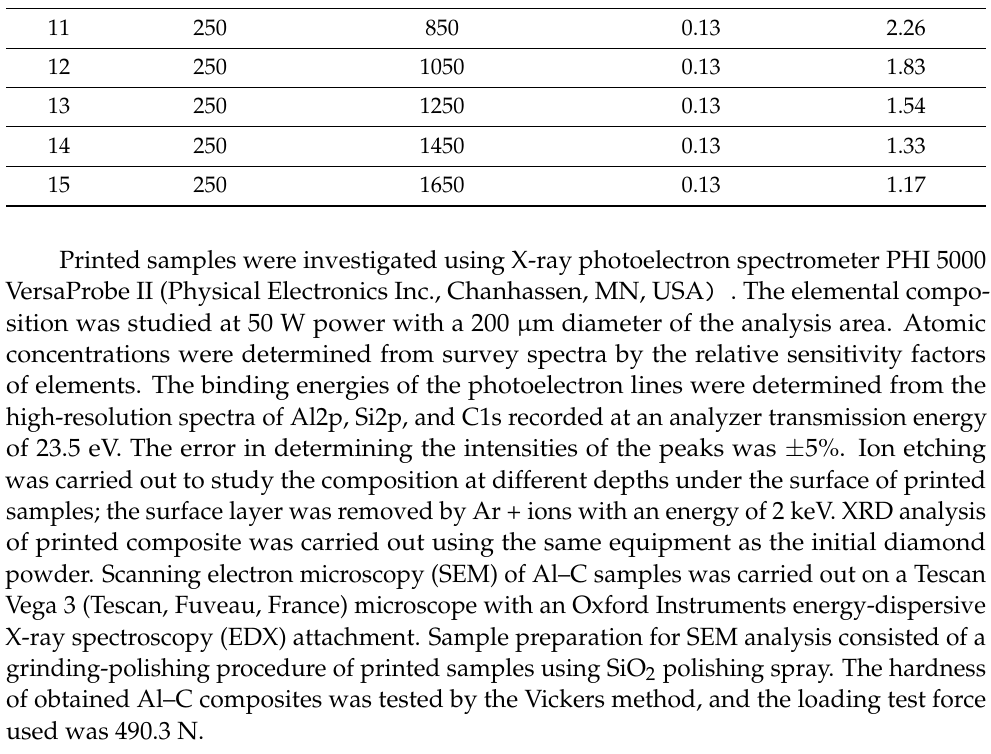
Figure 2. TEM images of the diamond powder with 500 nm fraction. The XRD diffraction pattern of initial diamond particles is shown in Figure 3. Two distinct peaks characterize the diamond phase; there were no metal impurities detected. The SEM images provided in Figure 4 show aluminum powder particles coated with a diamond fraction of 500 nm in a roller mill. It could be seen that powder particles were covered with several monolayers of diamond particles. Since the concentration of the cov- ering diamond particles is less than 1 wt %, the spectra were recorded by Thermo DXR Raman Imaging Microscope using Raman light scattering, and the results are shown in Figure 5.